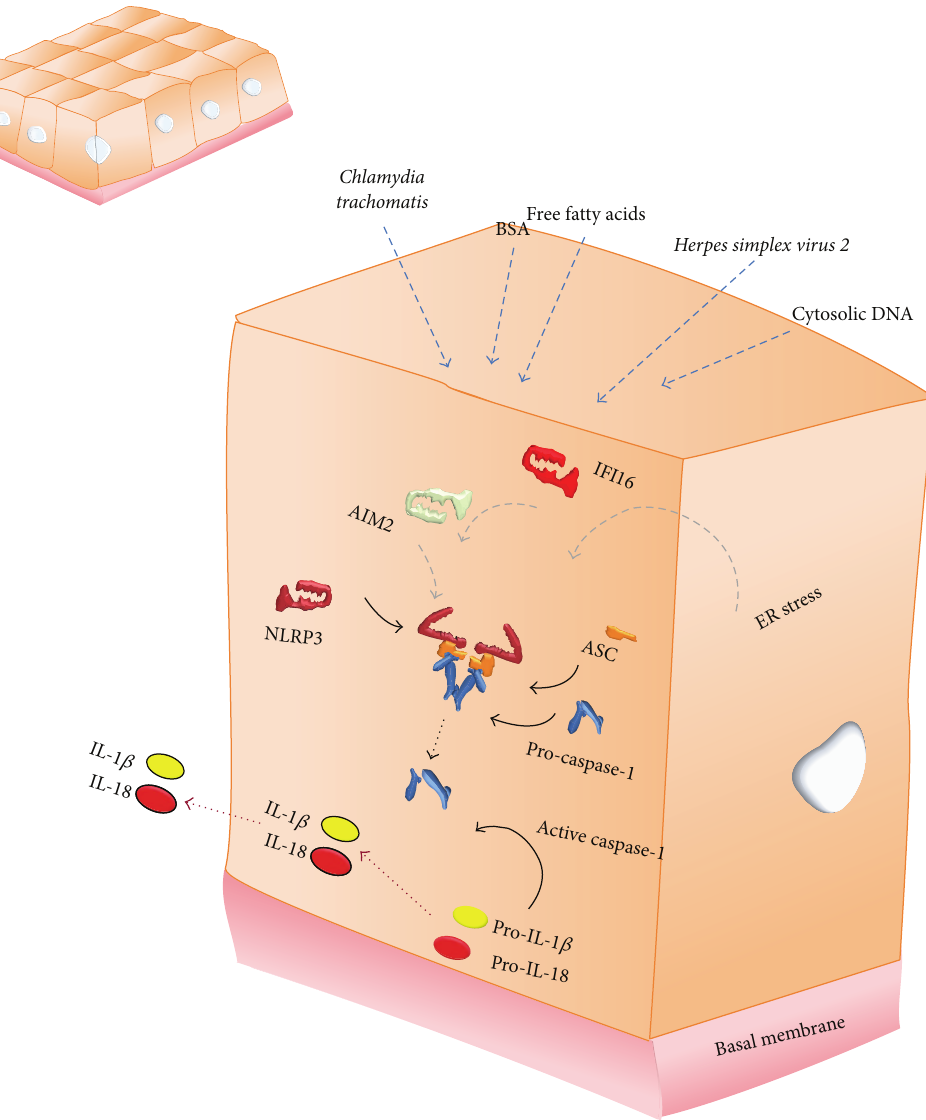
Figure 5: Schematic representations of simple cuboidal epithelial cells lining the urogenital tract in which different inflammasomes have been described to be activated by independent instigators triggering the release of inflammasome